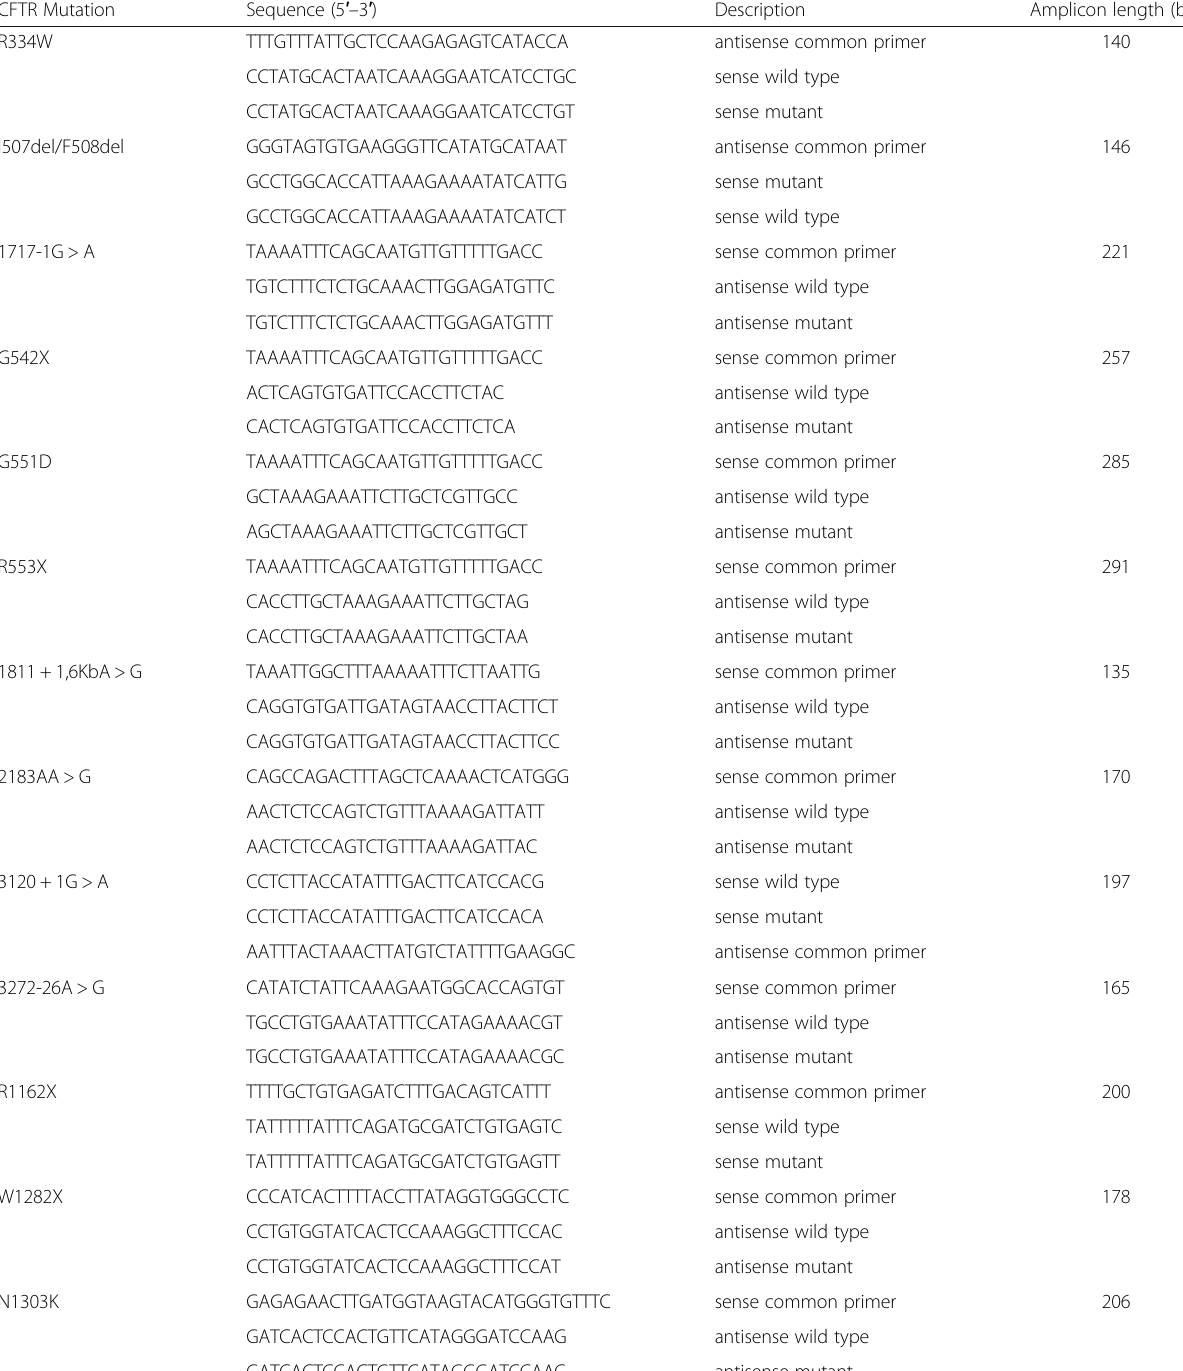
Table 1 Primer sets used for detecting CFTR gene mutations. The same set of primers was used for detecting mutations I507del and F508del. Primers flank 13 targets and allow the detection of 14 CFTR mutations CFTR Mutation Sequence (5 ′– 3 ′